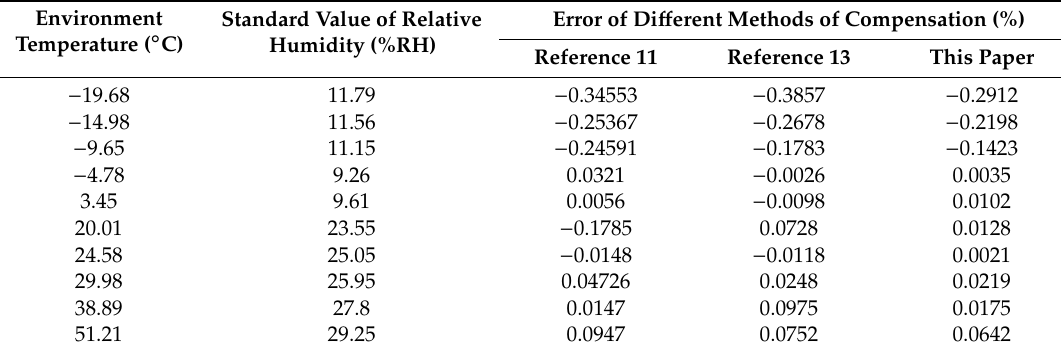
Table 1. Error after compensation of three methods.